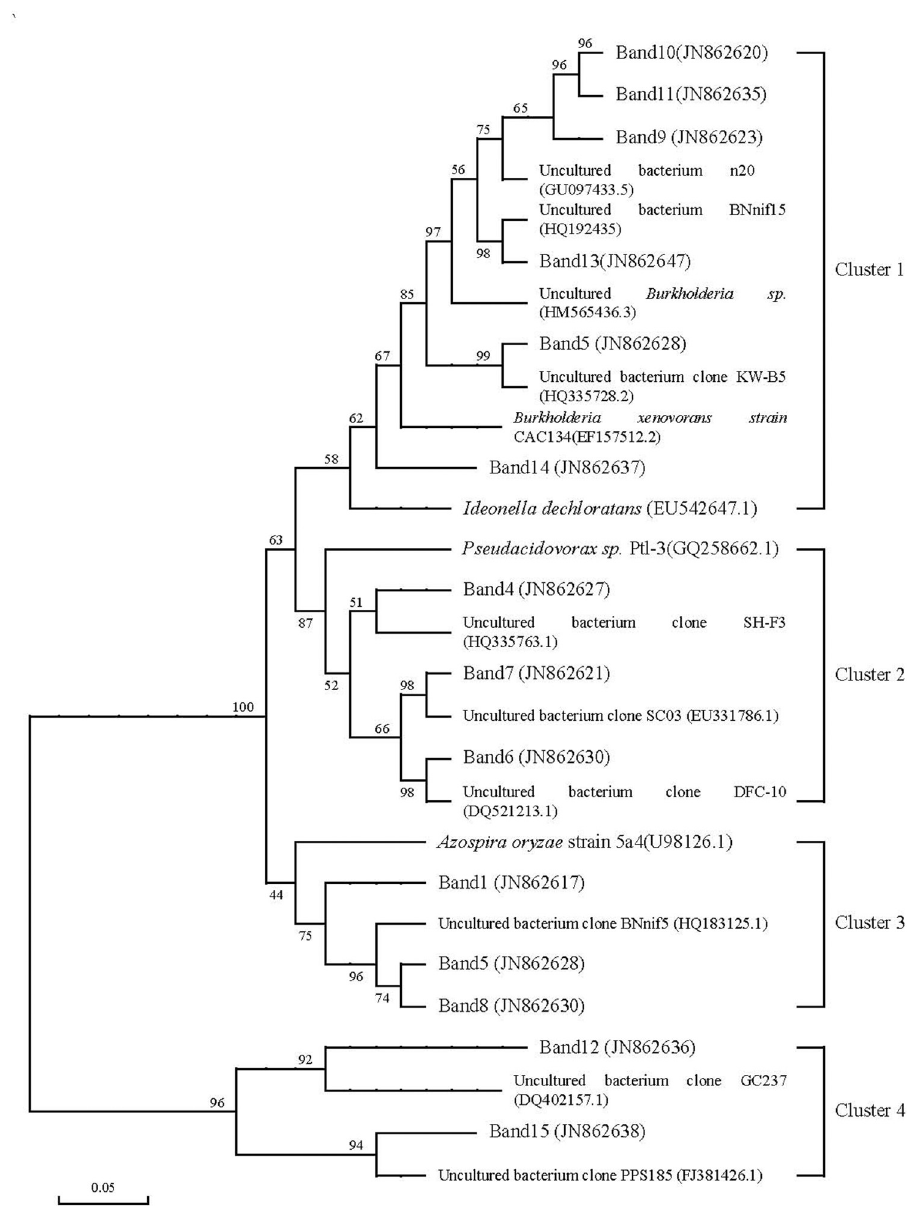
Fig 3. Phylogenetic tree of cbbL R gene in soil samples by using all OTUs identified with different long-term fertilizer treatments. of cbbL R genes were belong to the cluster 1 lineage, and some cbbL R genes were belong to the cluster 2 lineage, cluster 3 lineage and cluster 4 lineage in all soil samples (Fig 3). In the first cluster, Band 9, 10, 11 and Band 13 were clustered with soil N-fixing bacteria HM565436.3, Band 5 were clustered with soil bacteria HQ335728.2, Band 14 were clustered with Ideolla decloratans strain EU542647.1. In the second cluster, Band 4, 6 and Band 7 were similar to Pseudoacidovorax . Band 1, 5, Band 8 and Azospira were affiliated with the third cluster, Band 12 and Band 15 were significantly differences from the other sequences.